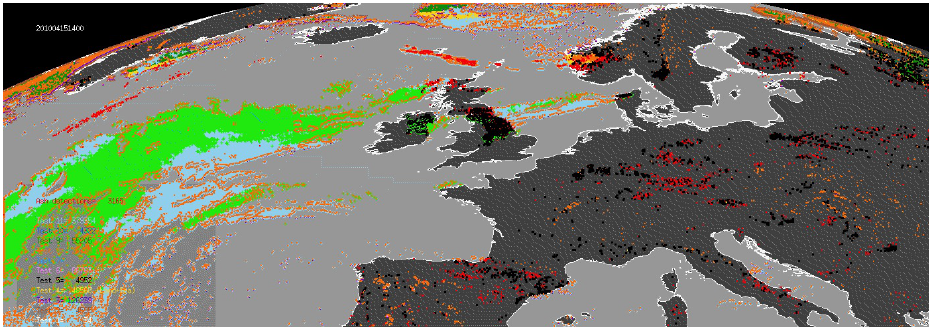
Figure 17. Cloud identification scheme (CID) image with colours identifying which tests have been flagged for each pixel. Pixels coloured red are ones that are finally identified as containing ash. Note that some pixels over the land are wrongly identified as ash. The colour legend may be found in Figure 18. Date:2010.04.15 Time:14:00UTC